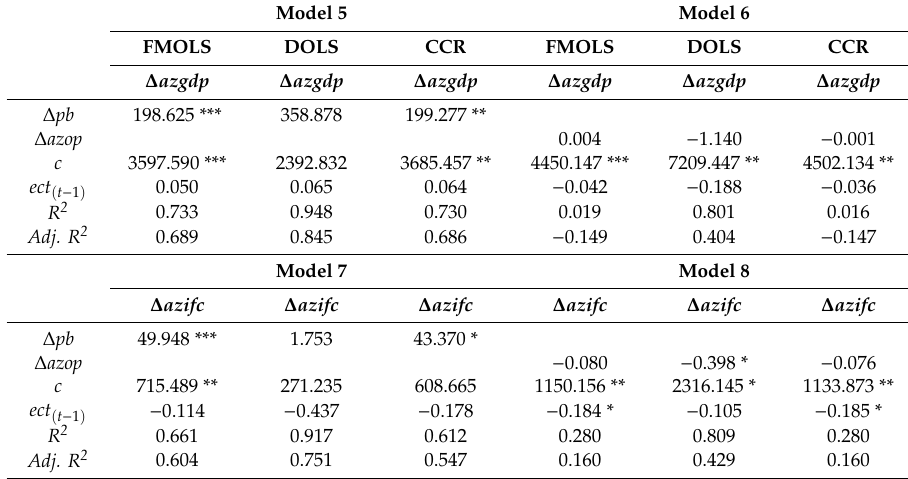
Table 9. The influence of oil price and oil production on GDP and investment on fixed capital (Azerbaijan).